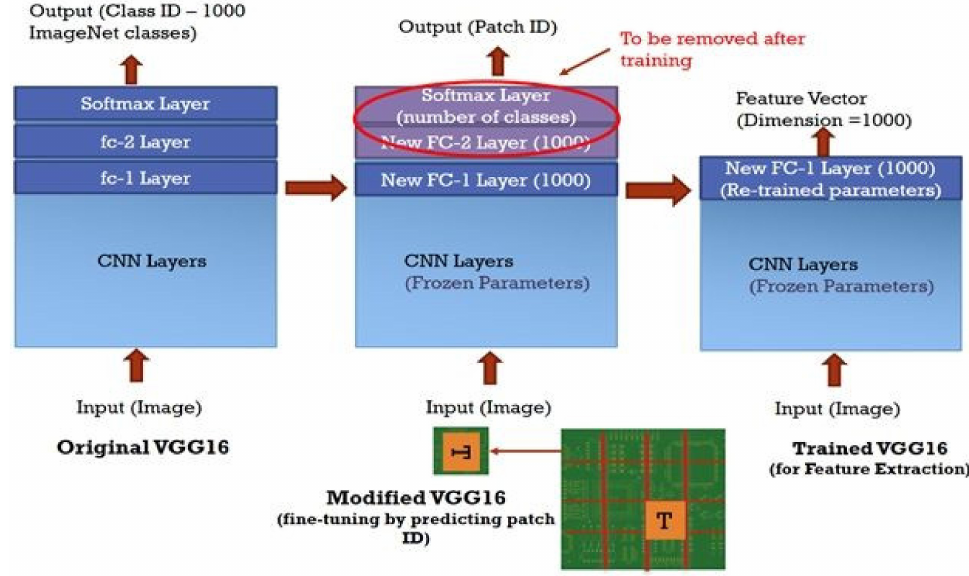
Figure 5. Modified VGG16 deep network (architecture A1).